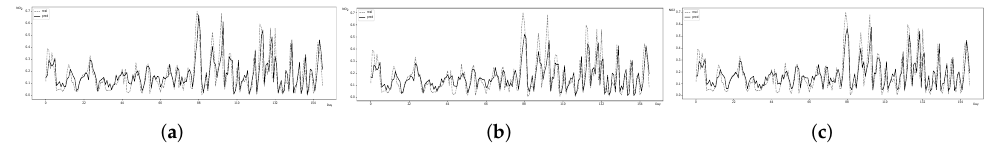
Figure 16. Predicted versus actual normalized output values with different number of dense layers. ( a ) 1 dense layer. ( b ) 3 dense layers. ( c ) 5 dense layers.